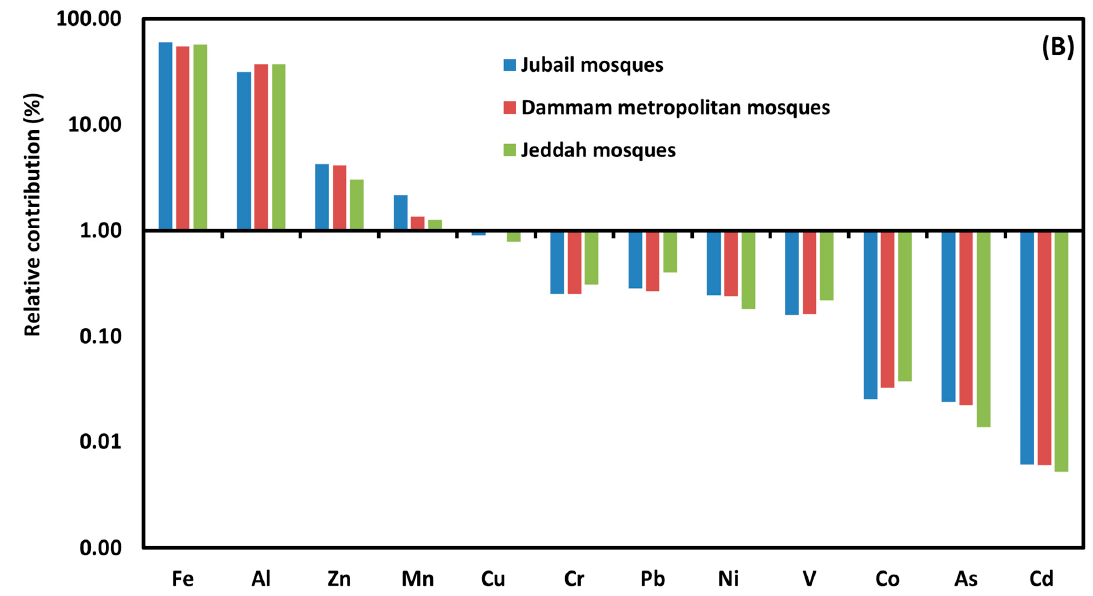
Figure 3. Relative contribution (%) of each PHE to ∑ PHEs concentrations in ACFD of mosques located in different functional areas of Jubail and Jeddah cities and Dammam metropolitan area ( A ), and in ACFD of Jubail, Jeddah and Dammam metropolitan area mosques ( B ).